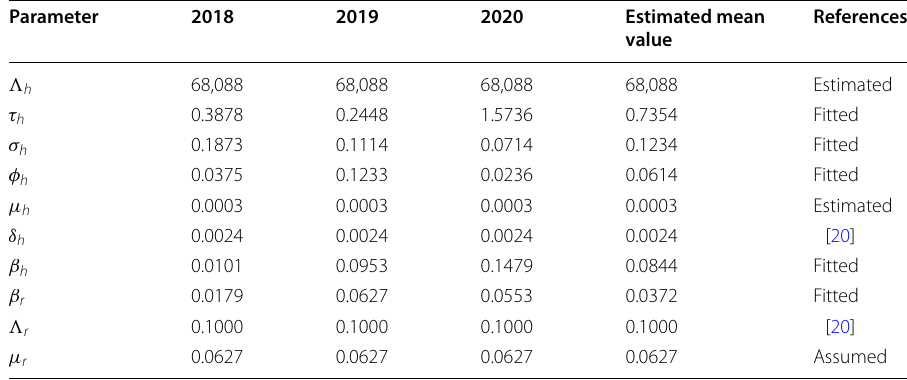
Table 2 Values of the parameters of the Lassa fever model (1)